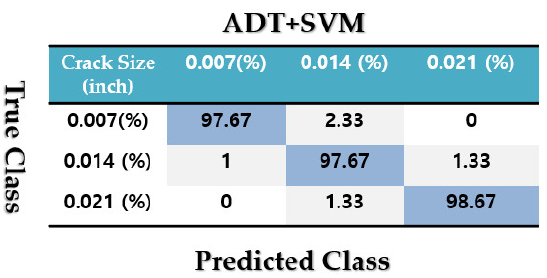
Figure 16. The average accuracies of crack size identification for the RF, IF, and OF using the pro- posed ADT+SVM scheme.